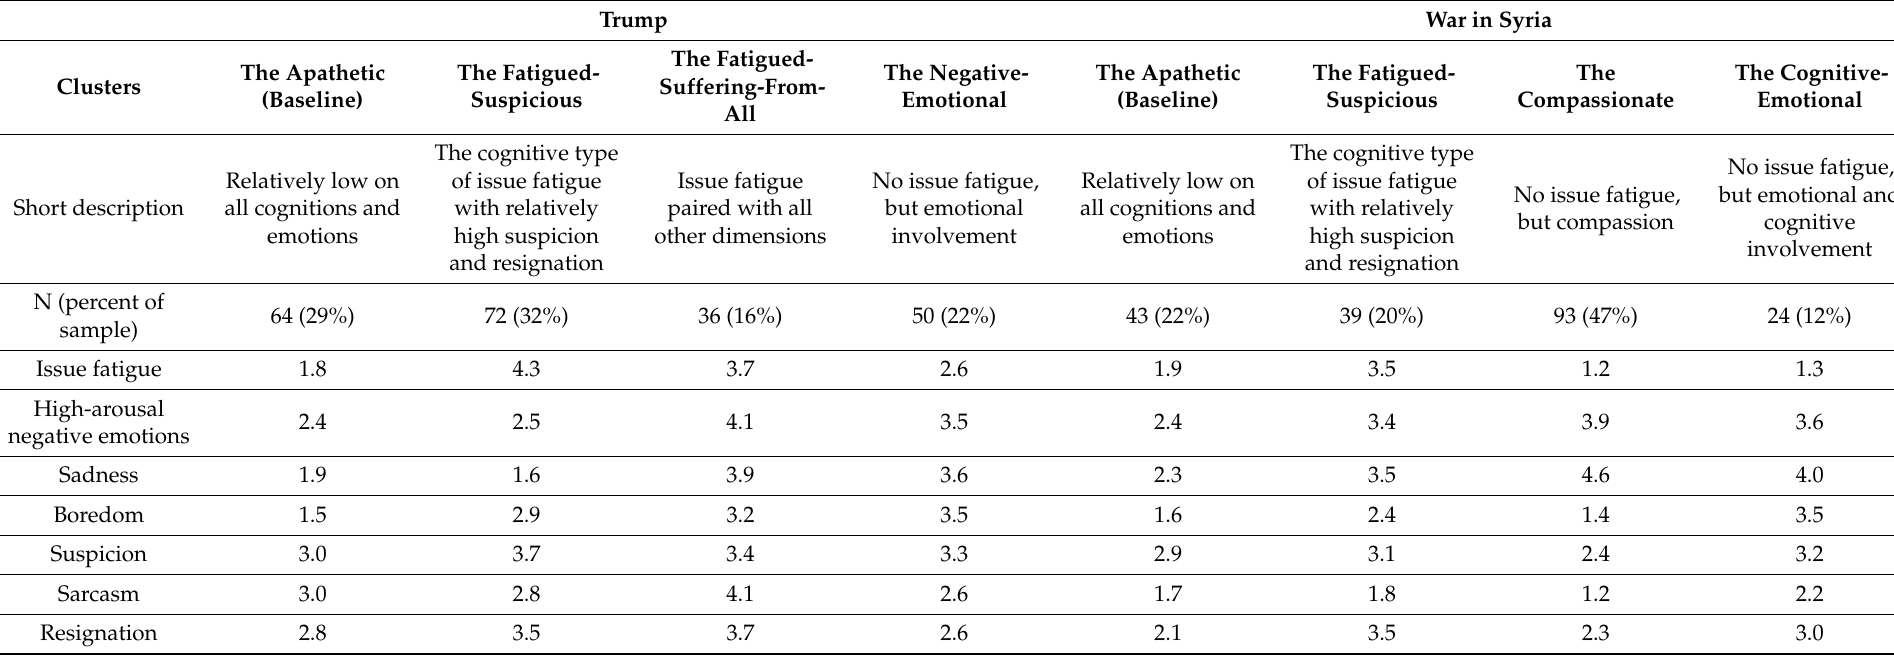
Table 3. Types of issue fatigue: combinations of primary and secondary emotions and cognitions (cluster analysis).